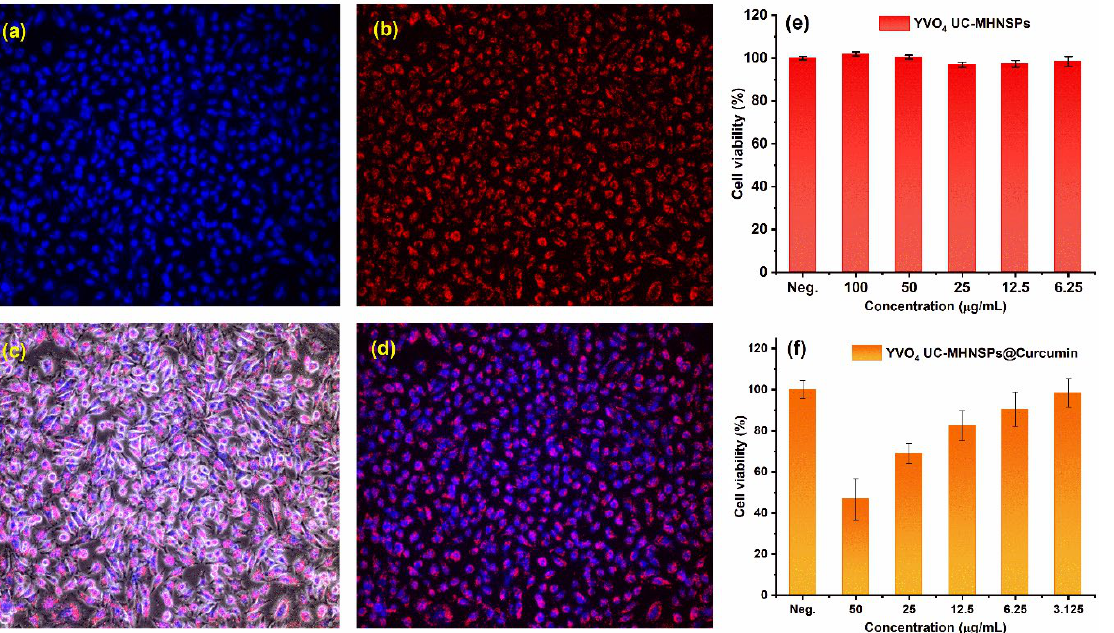
Figure 8. In vitro fluorescence images of YVO 4 :Er 3+ /Yb 3+ UC-MHNSPs uptake by HeLa cell lines, ( a ) nuclear stain (Hoechst 33342), ( b ) red emission from YVO 4 :Er 3+ /Yb 3+ UC-MHNSPs, ( c , d ) merged fluorescence bright-field and dark-field pictures of HeLa cells under 980 nm excitation. ( e ) Cell viability assessed by CCK-8 assay after incubating with various quantities of YVO 4 :Er 3+ /Yb 3+ UC-MHNSPs for 24 h and ( f ) antitumor activity of YVO 4 :Er 3+ /Yb 3+ UC-MHNSPs after conjugation with different quantities of curcumin.